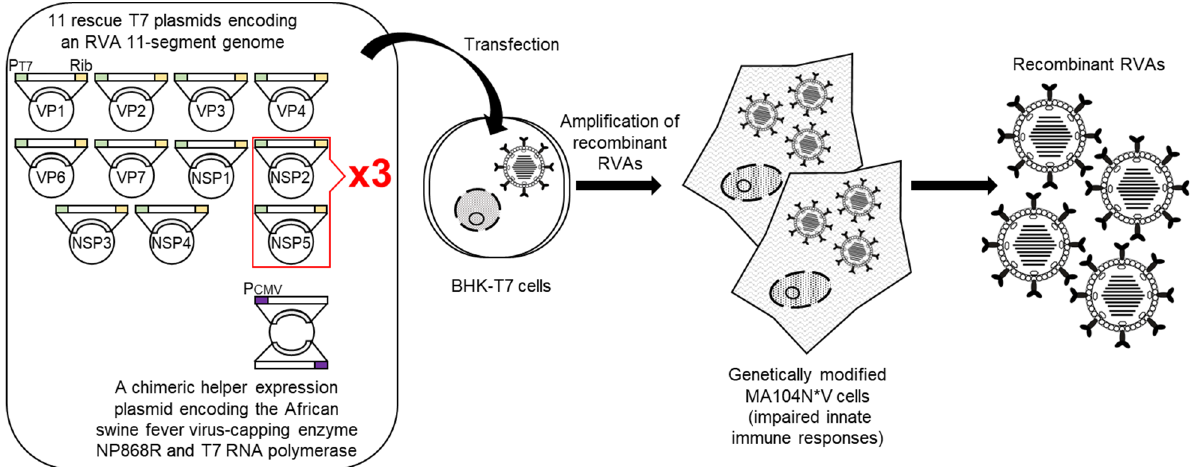
Figure 2. Schematic representation of Sánchez-Tacuba’s reverse genetics system. BHK-T7 cells are transfected with a set of 11 rescue T7 plasmids encoding an RVA genome with 3-fold increased proportions of T7 plasmids for the NSP2 and NSP5 genes compared to the other nine T7 plasmids, as well as a chimeric helper expression plasmid for the African swine fever virus-capping enzyme NP868R and T7 RNA polymerase. Next day, the transfected BHK-T7 cells are overlaid with genetically modified MA104N*V cells with impaired innate immune responses and then co-cultured for 3 days for amplification of recombinant RVAs. Infectious recombinant RVAs can be rescued from the co-cultures. PT7, Rib, and PCMV denote the T7 RNA polymerase promoter, HDV ribozyme, and cytomegalovirus promoter sequence, respectively.